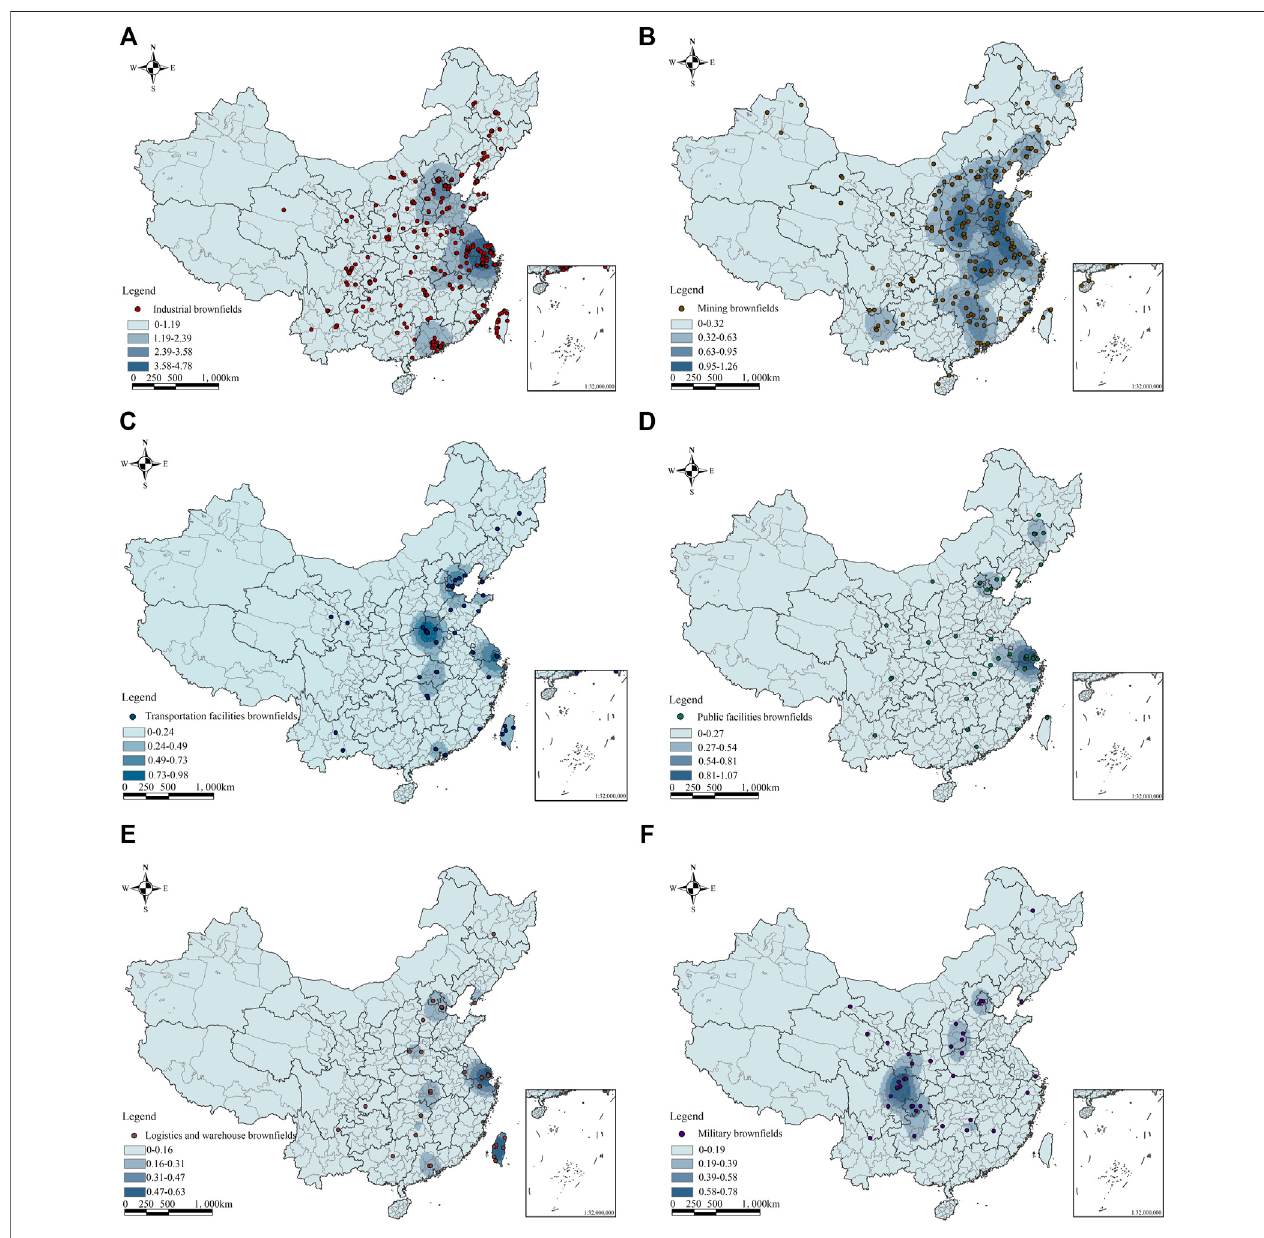
FIGURE3| Kerneldensityestimationofsixbrown fi eldtypesinChina. (A) Industrialbrown fi elds. (B) Miningbrown fi elds. (C) Transportationfacilitiesbrown fi elds. (D) Public facilities brown fi elds. (E) Logistics and warehouse brown fi elds. (F) Military brown fi elds.